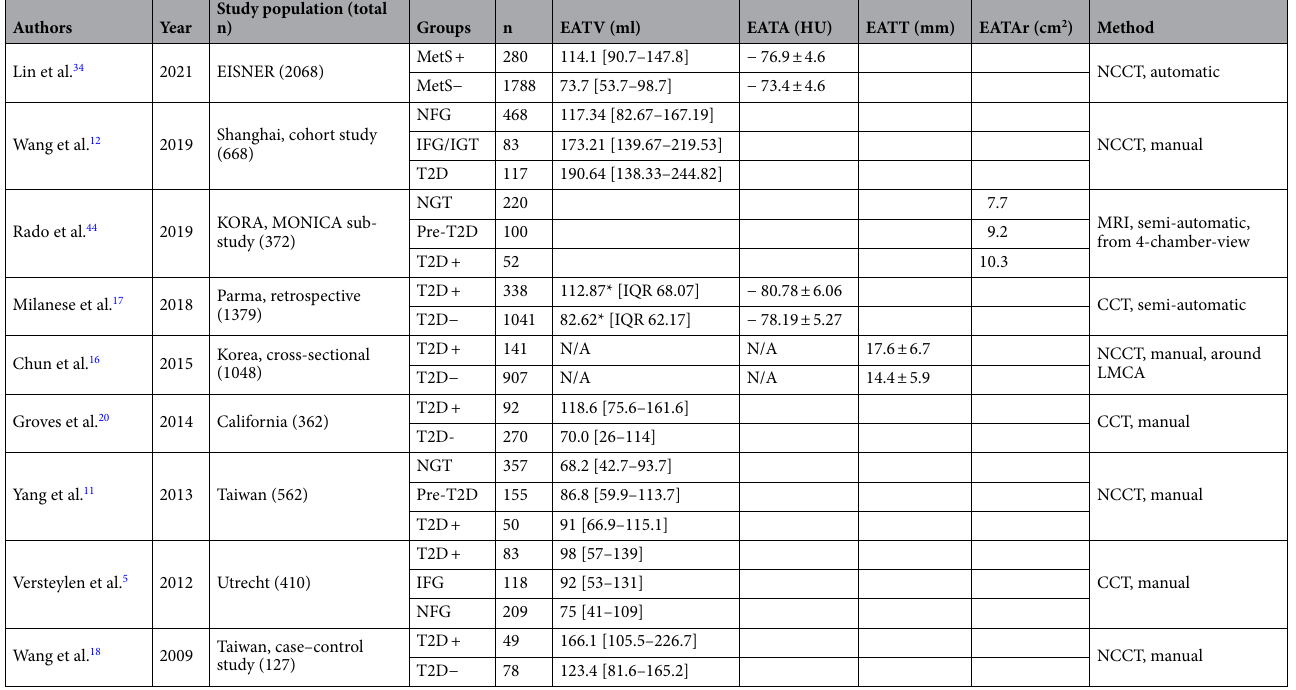
Table 2. Overview of the most important studies in the field with regards to cohort size and/or techniques applied, arranged in inverse chronological order. T2D type-2 diabetes, IFG impaired fasting glucose, IGT impaired glucose tolerance, pre-T2D pre-diabetes, NFT normal fasting glucose, NGT normal glucose tolerance, MetS metabolic syndrome, EATV epicardial adipose tissue volume, EATA epicardial adipose tissue attenuation, EATT epicardial adipose tissue thickness, EATAr epicardial adipose tissue area, VAT visceral adipose tissue, NCCT non-contrast computed tomography, CCT contrast computed tomography, MRI magnetic